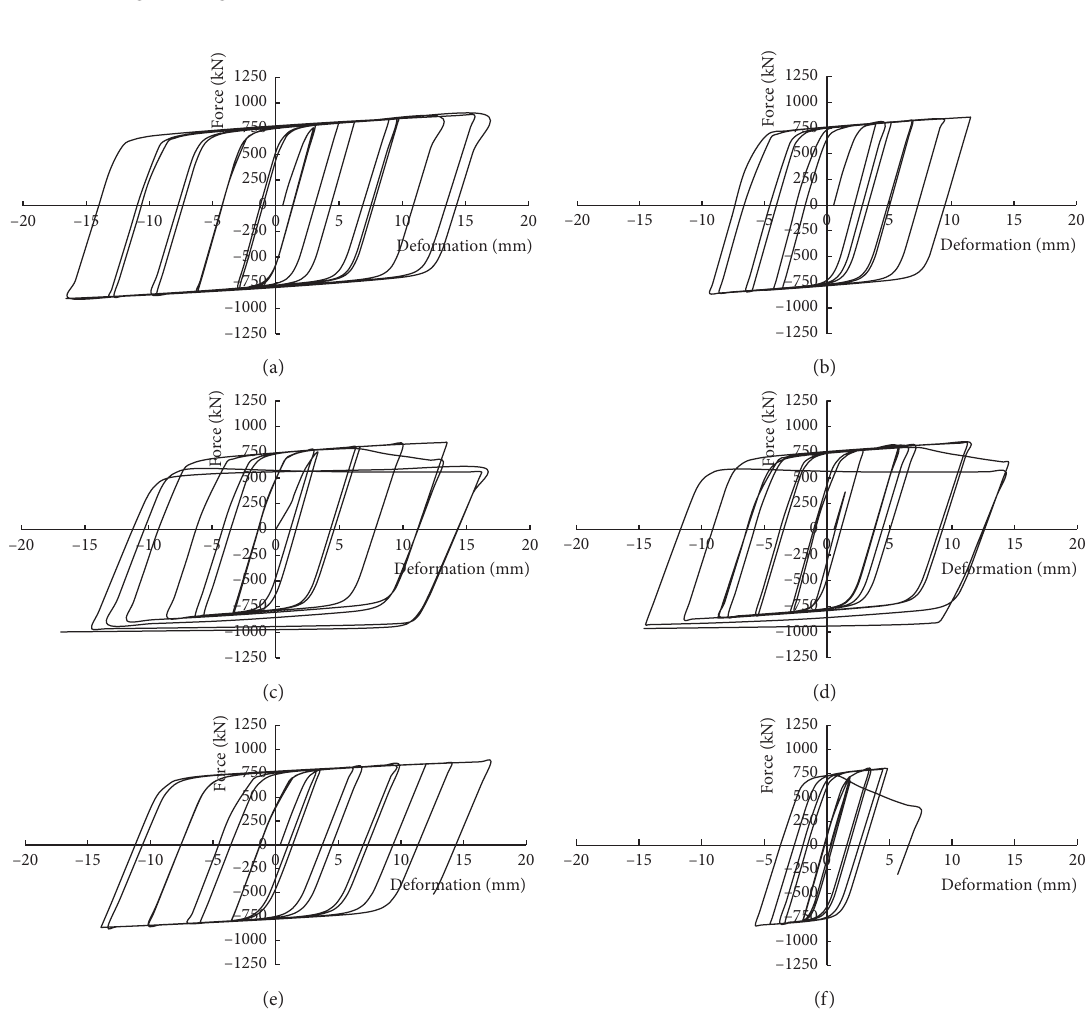
Figure 8: Shear force-displacement curves of the models. (a) PEC-1. (b) PEC-2. (c) PEC-3. (d) PEC-4. (e) PEC-5. (f) PEC-6.